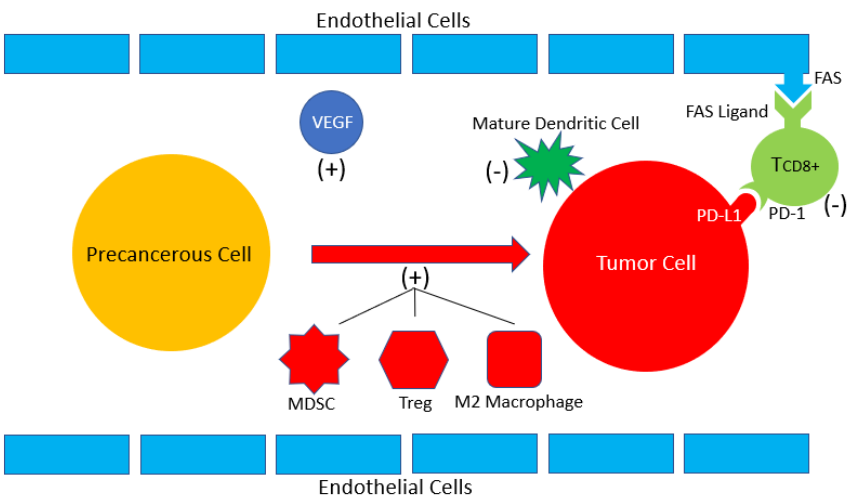
Figure 1. VEGF promotes many immune mediated effects that promotes tumorigenesis. VEGF upregulates immunosuppressive cells such as myeloid-derived suppressor cells (MDSCs), T regulatory cells (Treg), and M2 macrophages which promote tumor cell formation as indicated by the (+) sign. In addition, VEGF prevents the maturation of dendritic cells and reduces the effectiveness and number of CD8+ T cells by inducing PD1/PD-L1 interactions and by promoting FAS binding. Because dendritic cells and CD8+ T cells normally inhibit tumorigenesis, a (-) sign is seen adjacent to their depictions.